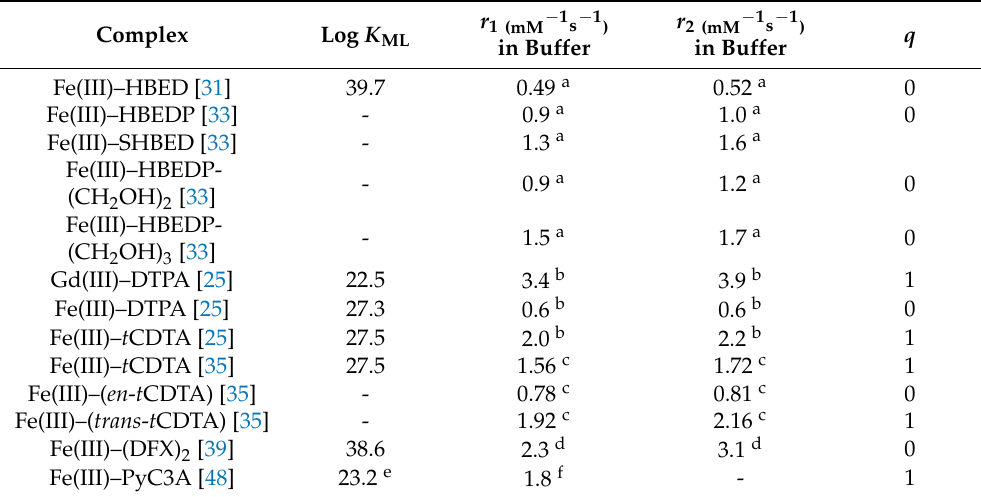
Figure 5. ( a ) Chemical structures of Fe(II) – PyC3A, Fe(III) – PyC3A, and reversible transformation between them with oxidation and reduction. ROS represent the reactive oxygen species. ( b ) T 1-weighted images of saline and caerulein/LPS-treated mice recorded before and after injection of 0.2 mmol/kg Fe(II) – PyC3A [48]. Organs in Figure b are labeled as follows: bowel (B), kidney (K), muscle (M), pancreas (P), Sp (spleen), and St (stomach). Reprinted/adapted with permission from Ref. [48]. Copyright 2019 American Chemical Society. Table 1. Formation constants (log K ML ), relaxivity ( r 1 , r 2 ), and hydration state ( q ) for mononuclear Fe(III) complexes with open ligands.